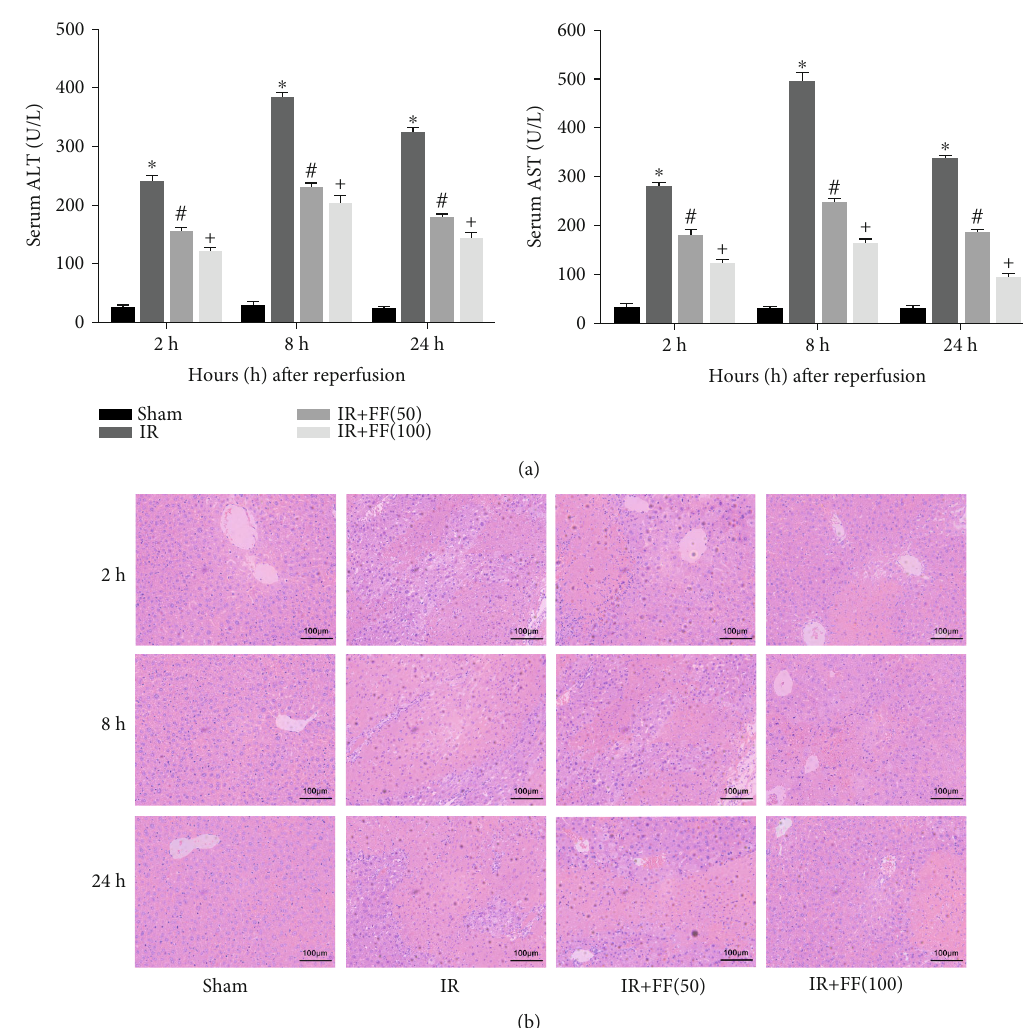
Figure 1: Feno fi brate pretreatment ameliorated hepatic function in IR-induced liver injury. (a) The levels of serum ALT and AST are presented as mean ± SD ( n = 6 ; ∗ P < 0 : 05 for IR vs. sham; # P < 0 : 05 for IR+FF (50) vs. IR; + P < 0 : 05 for IR+FF (100) vs. IR; ^ P < 0 : 05 for IR+FF (50) vs. IR+FF (100)). (b) Liver sections were stained with H&E and examined under light microscopy (magni fi cation,